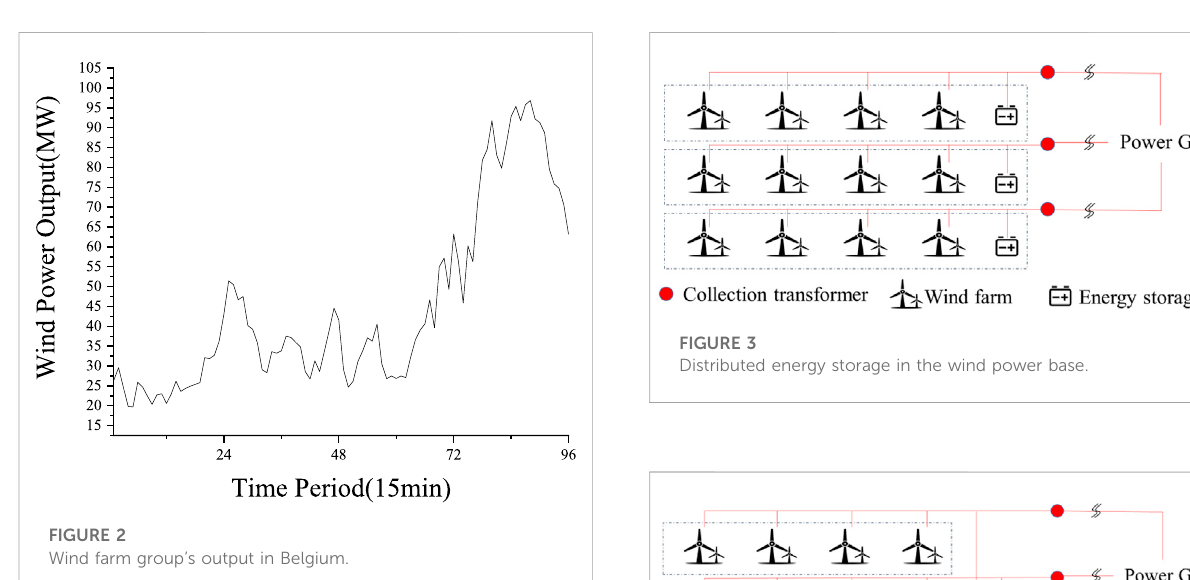
FIGURE 2 Wind farm group ’ s output in Belgium.